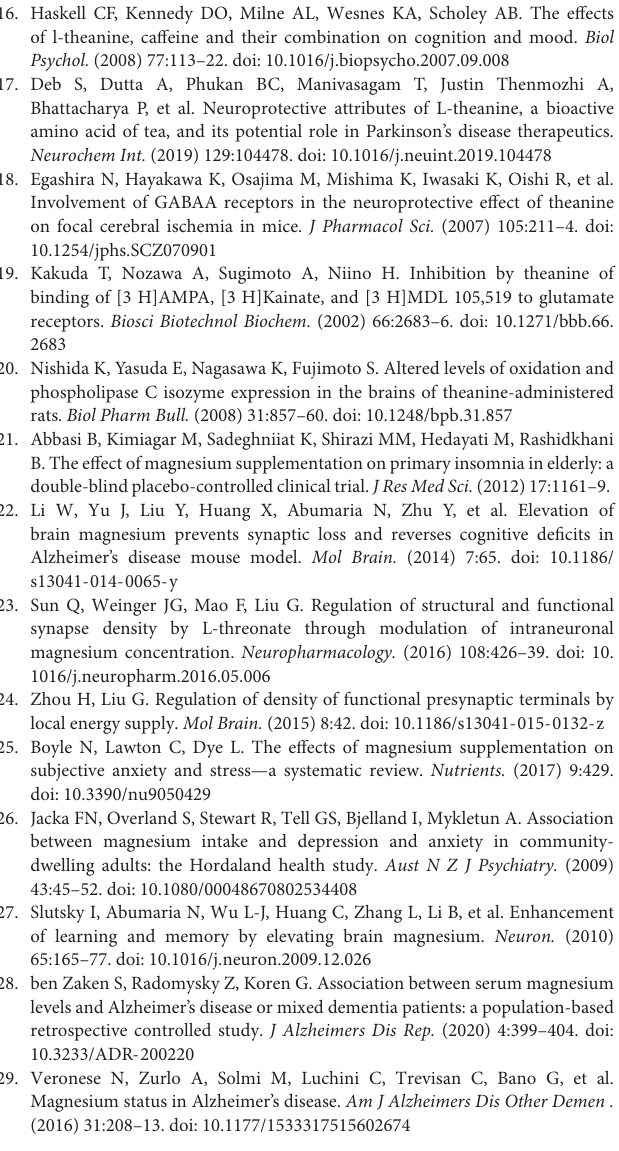
Supplementary Figure 1 | Frequency – power graphs of L -theanine (A) , Mg-T1 (B) , and Mg-T2 (C) at 50th and 100th minutes for 30–100 Hz range. Average of the 1200 FFT (10 min following 50th and 100th minutes) results were calculated for each animal and data were represented as mean ± SEM